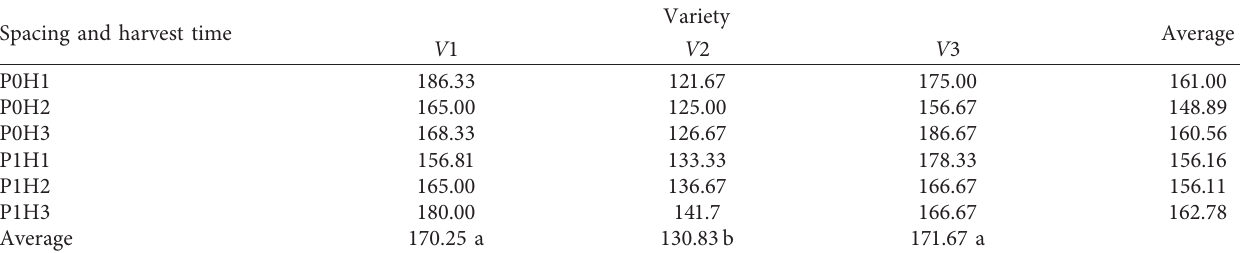
Table 3: Plant heights of sweet corn (cm) of different varieties and at different harvest times.